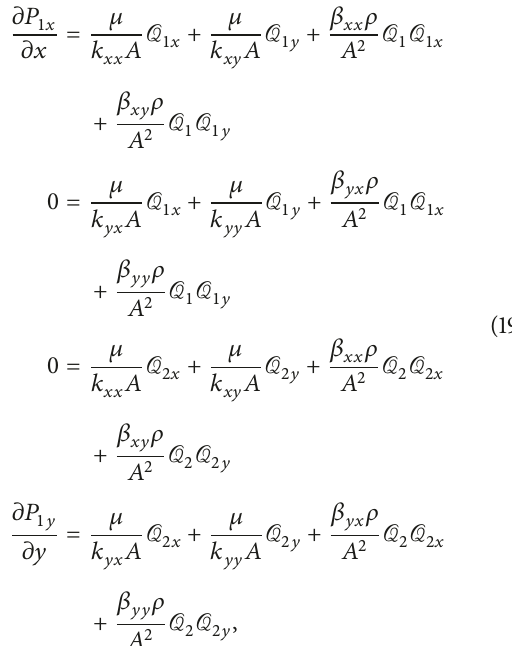
angle of 0 ∘ in the Darcy flow, from which the pore pressure variation of the flow in fractured rock can be obviously seen.